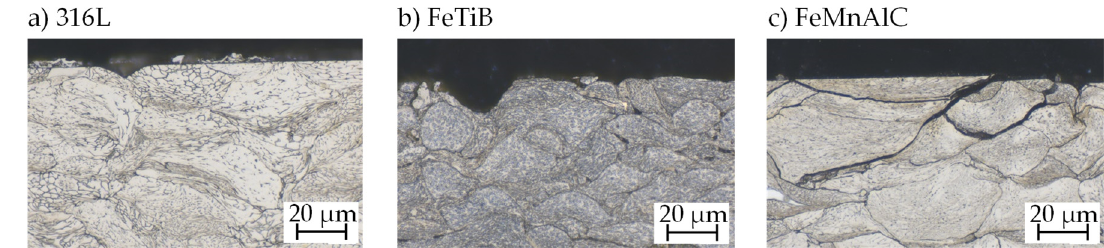
Figure 9. Microstructure after deep rolling with p r = 400 bar (no intermediate milling): ( a ) etched 20 s in 60% electrolytic HNO 3 (1.5 V); ( b , c ) etched 15–20 s in 3% alcoholic HNO 3 .